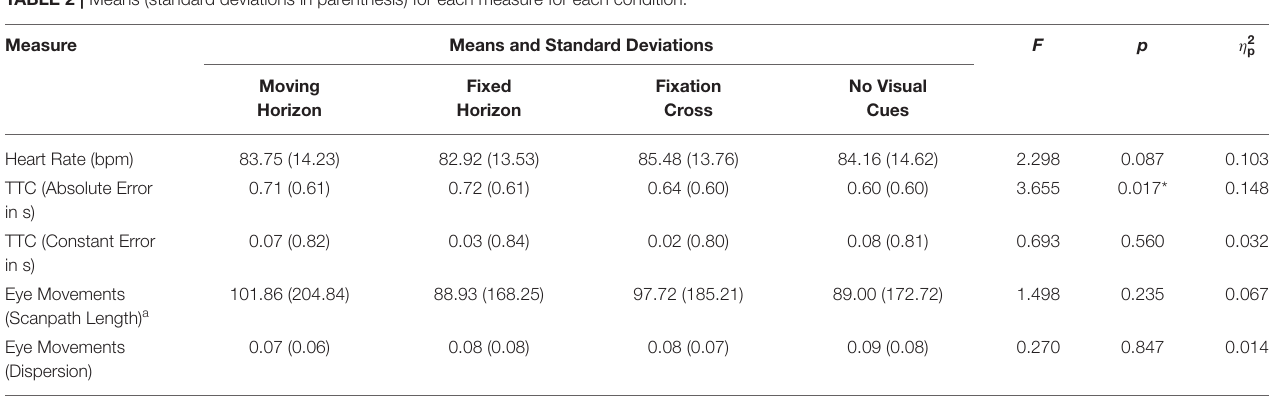
TABLE 2 | Means (standard deviations in parenthesis) for each measure for each condition.